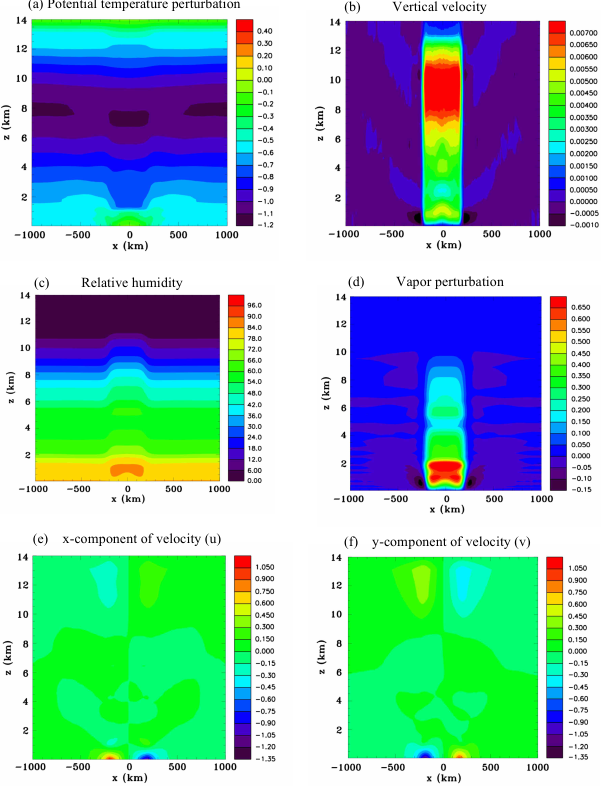
Figure 2. Vertical sections for Experiment 1: the maximum cooling aloft case, at t = 12h. (a) Potential temperature perturbation (K), (b) vertical velocity (ms − 1 ), (c) relative humidity, (d) vapor per- turbation (gkg − 1 ), (e) x -component of velocity, u (ms − 1 ), and (f) y -component of velocity, v (ms − 1 ).